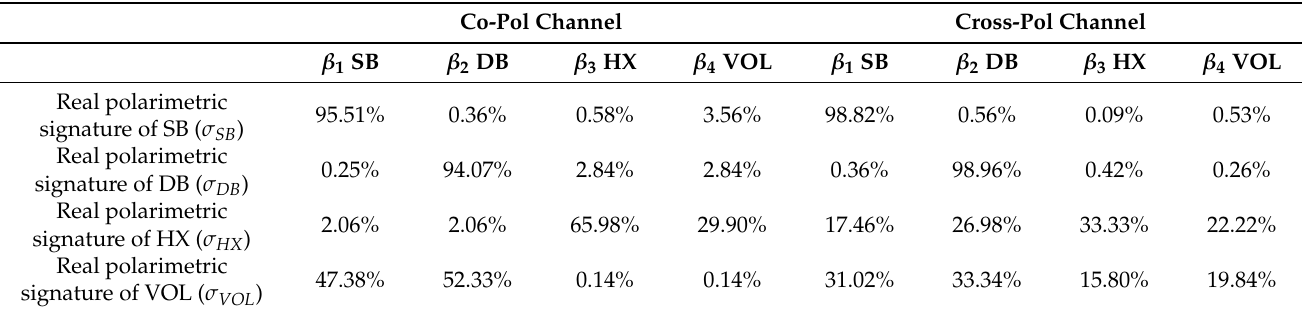
Table 10. Results of SIRT-based decomposition for real data (co- and cross-polarized channels). Recognized signatures are specified in percentage.